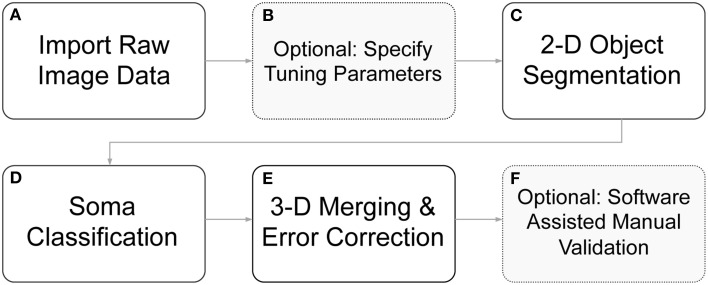
Flow diagram of segmentation routines. (A) Raw image z-stacks were imported into the program. (B) Prior to initiating cell segmentation, the user could optionally specify segmentation tuning parameters (otherwise default parameters were used). (C) Objects of interest, including potential somata, were identified in each 2-D frame in the z-stack. (D) The segmented objects were further separated into somata candidates and neurite fragments. (E) 2-D soma candidates were evaluated against objects in neighboring z-slice and were either stitched together into 3-D objects or removed from consideration. (F) Following automated segmentation and error correction, the user could choose to manually correct any remaining segmentation errors with click-commands from the mouse. During the 3-D merging routines, if an object failed to meet certain criteria, it was flagged to alert the user to a possible error.